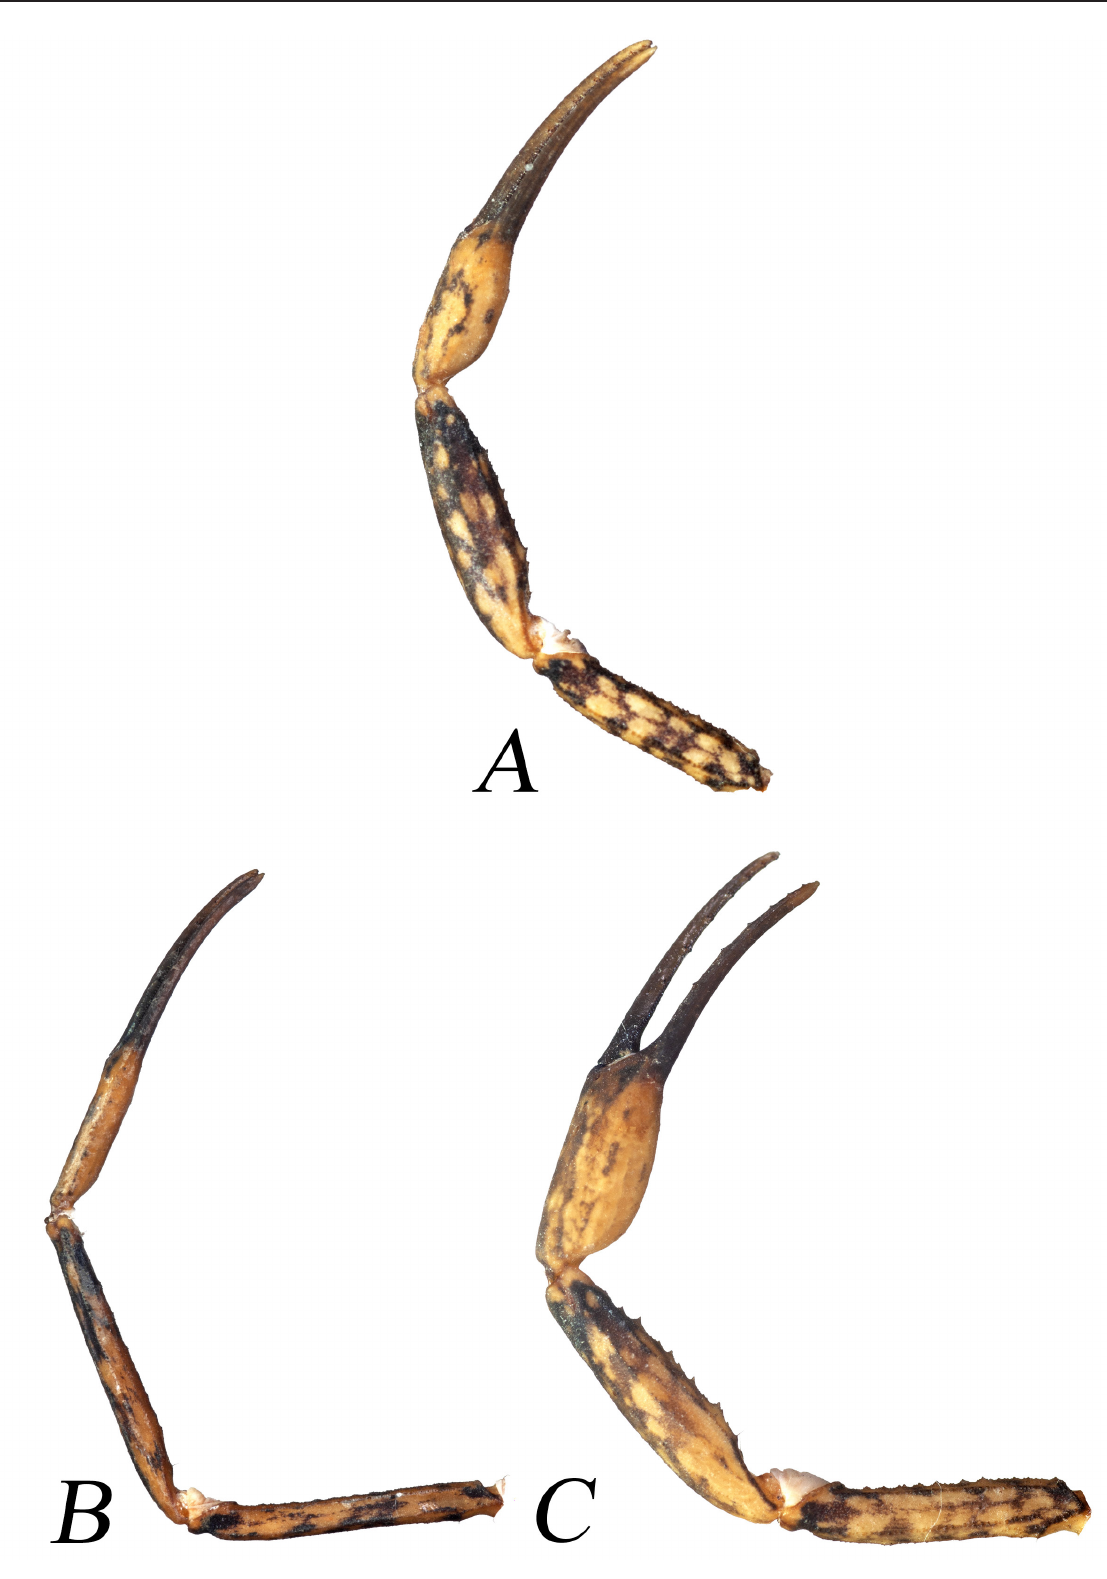
Fig. 25. Comparison of left pedipalps. A . Isometrus sankeriensis Tikader & Bastawade, 1983, neotype, adult ♂ (BNHS SC 194). B . I. nakshatra sp. nov., holotype, adult ♂ (BNHS SC 195). C . I. wayanadensis sp. nov., holotype, adult ♂ (BNHS SC